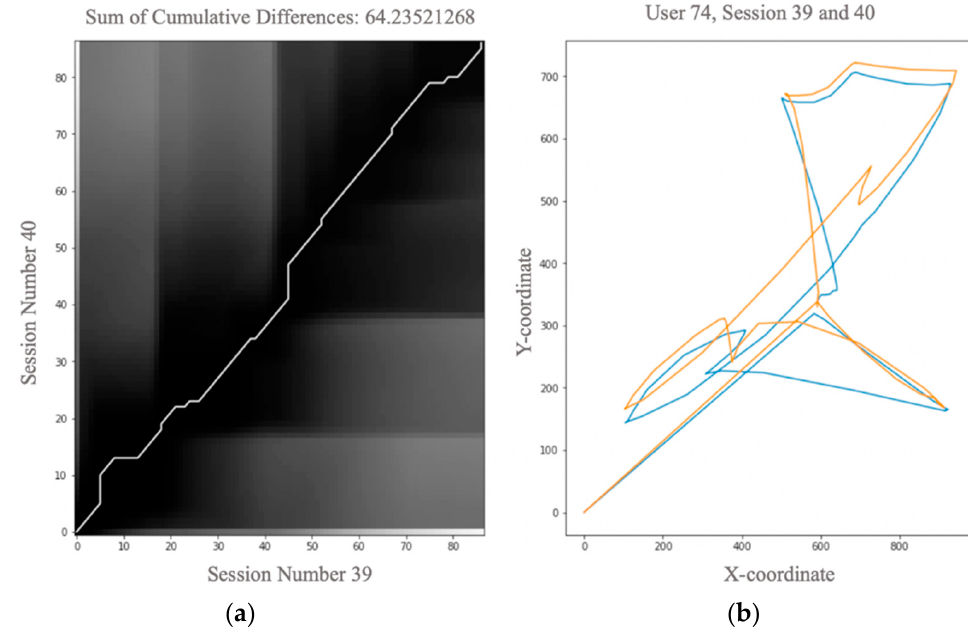
Figure 9. ( a ) Sum of cumulative DTW distance value in sessions generated by the same user, user 74; ( b ) Sessions 39 (blue) and 40 (orange) of user 74.